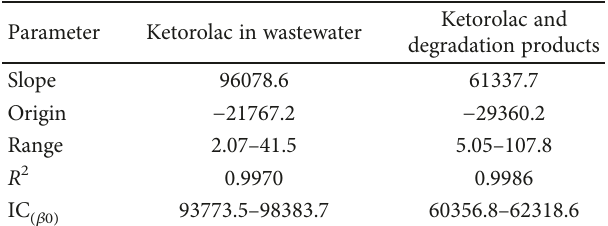
Table 4: Linearity results for the